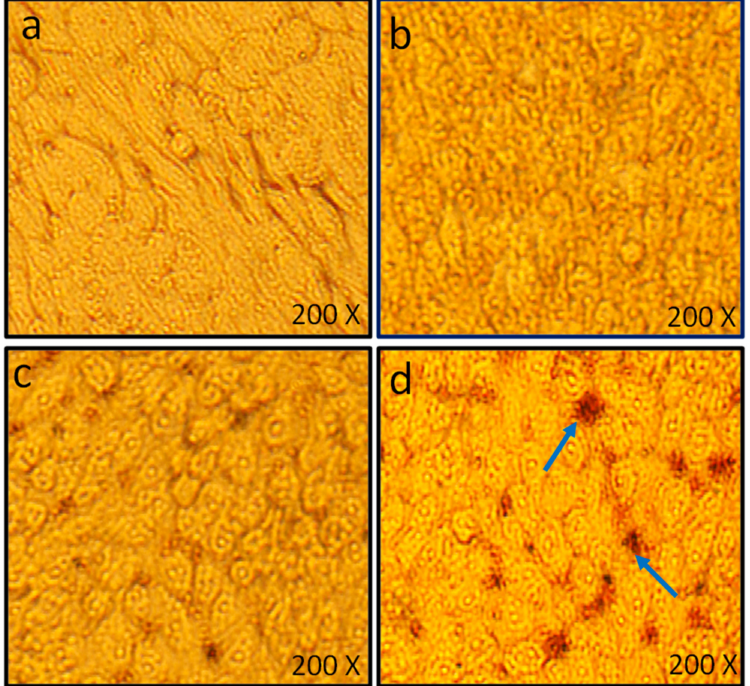
Figure 12. Microscopic analysis of HCT-116 cells exposed to varying concentrations of LIV-AgNPs for 24 h. Cytotoxic effects were manifested as shrunken morphology, gaps between the neighboring cells and cellular detachments, which appeared as round bodies in the culture medium. Images were captured at the magnification of 200X using a bright field inverted microscope (Olympus, CKX41, Tokyo, Japan). ( a ) HCT-116 untreated cells, ( b – d ) HCT-116 cells treated with—10, 50 and 100 µ g/mL of LIV-AgNPs,